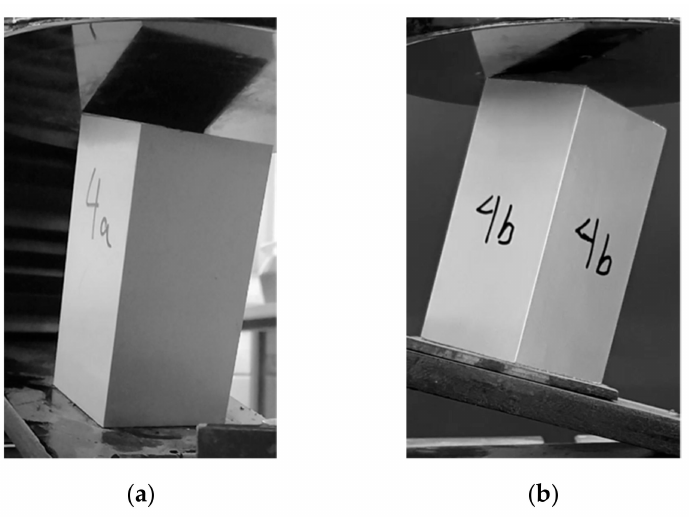
Figure 1. Experimental test configuration.